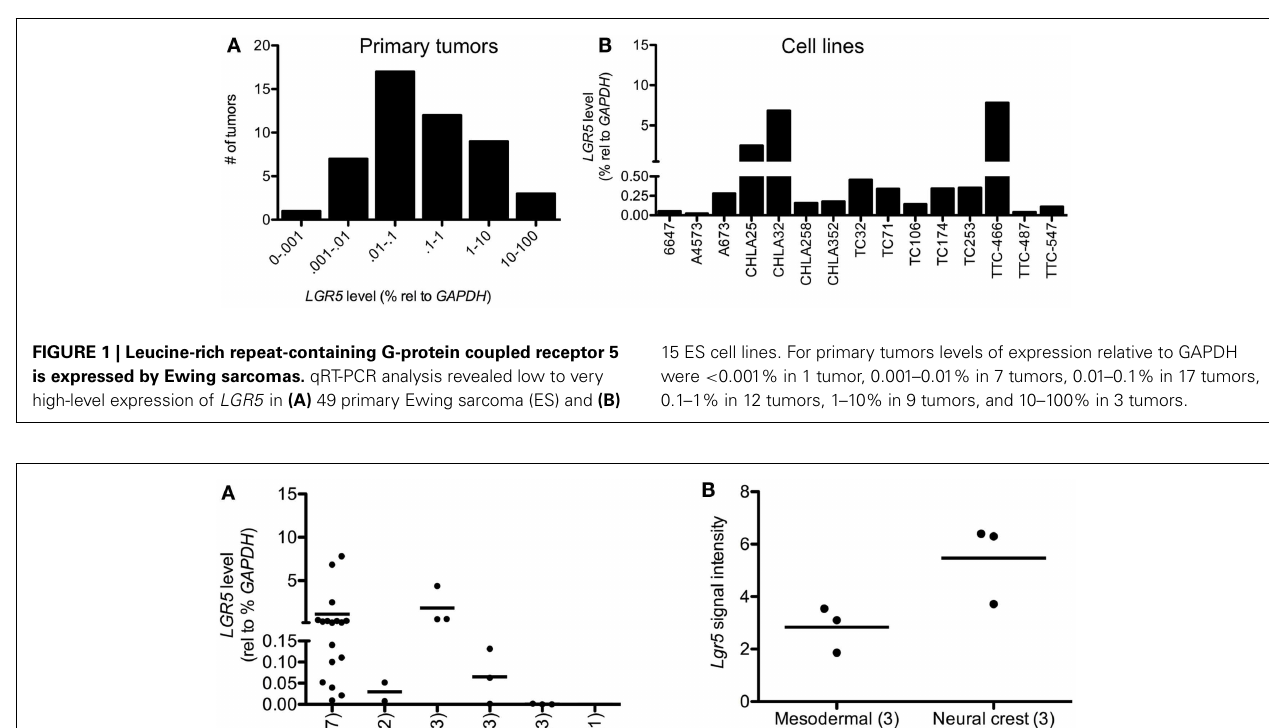
(MRC5) showed that undifferentiated hNCSC express the highest levels of LGR5 . (B) Murine bone marrow stromal cells of neural crest origin express higher levels of Lgr5 than cells of mesodermal origin (from publically available microarray data GEO accession GSE30419) (Wislet-Gendebien et al., 2012). N = 3 ± SEM. Lines represent arithmetic means of replicate